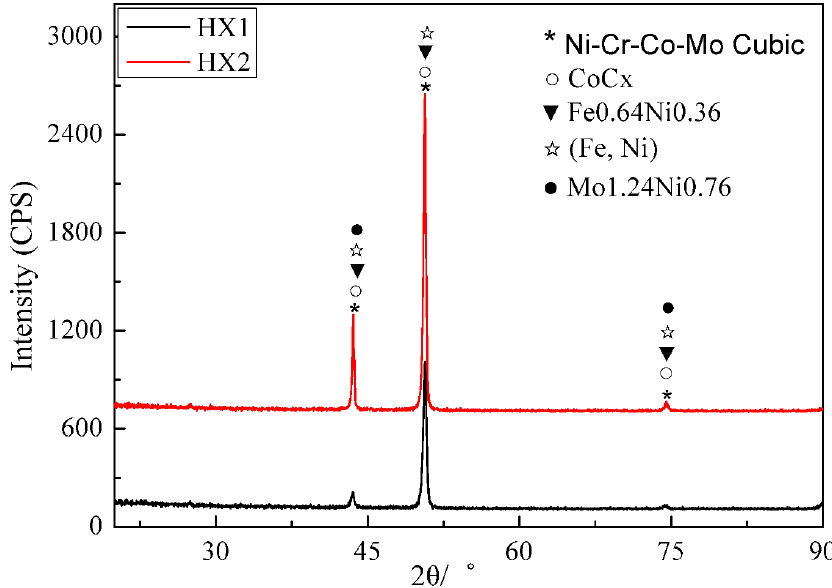
Figure 4. XRD patterns of the HX1 and HX2 coatings.